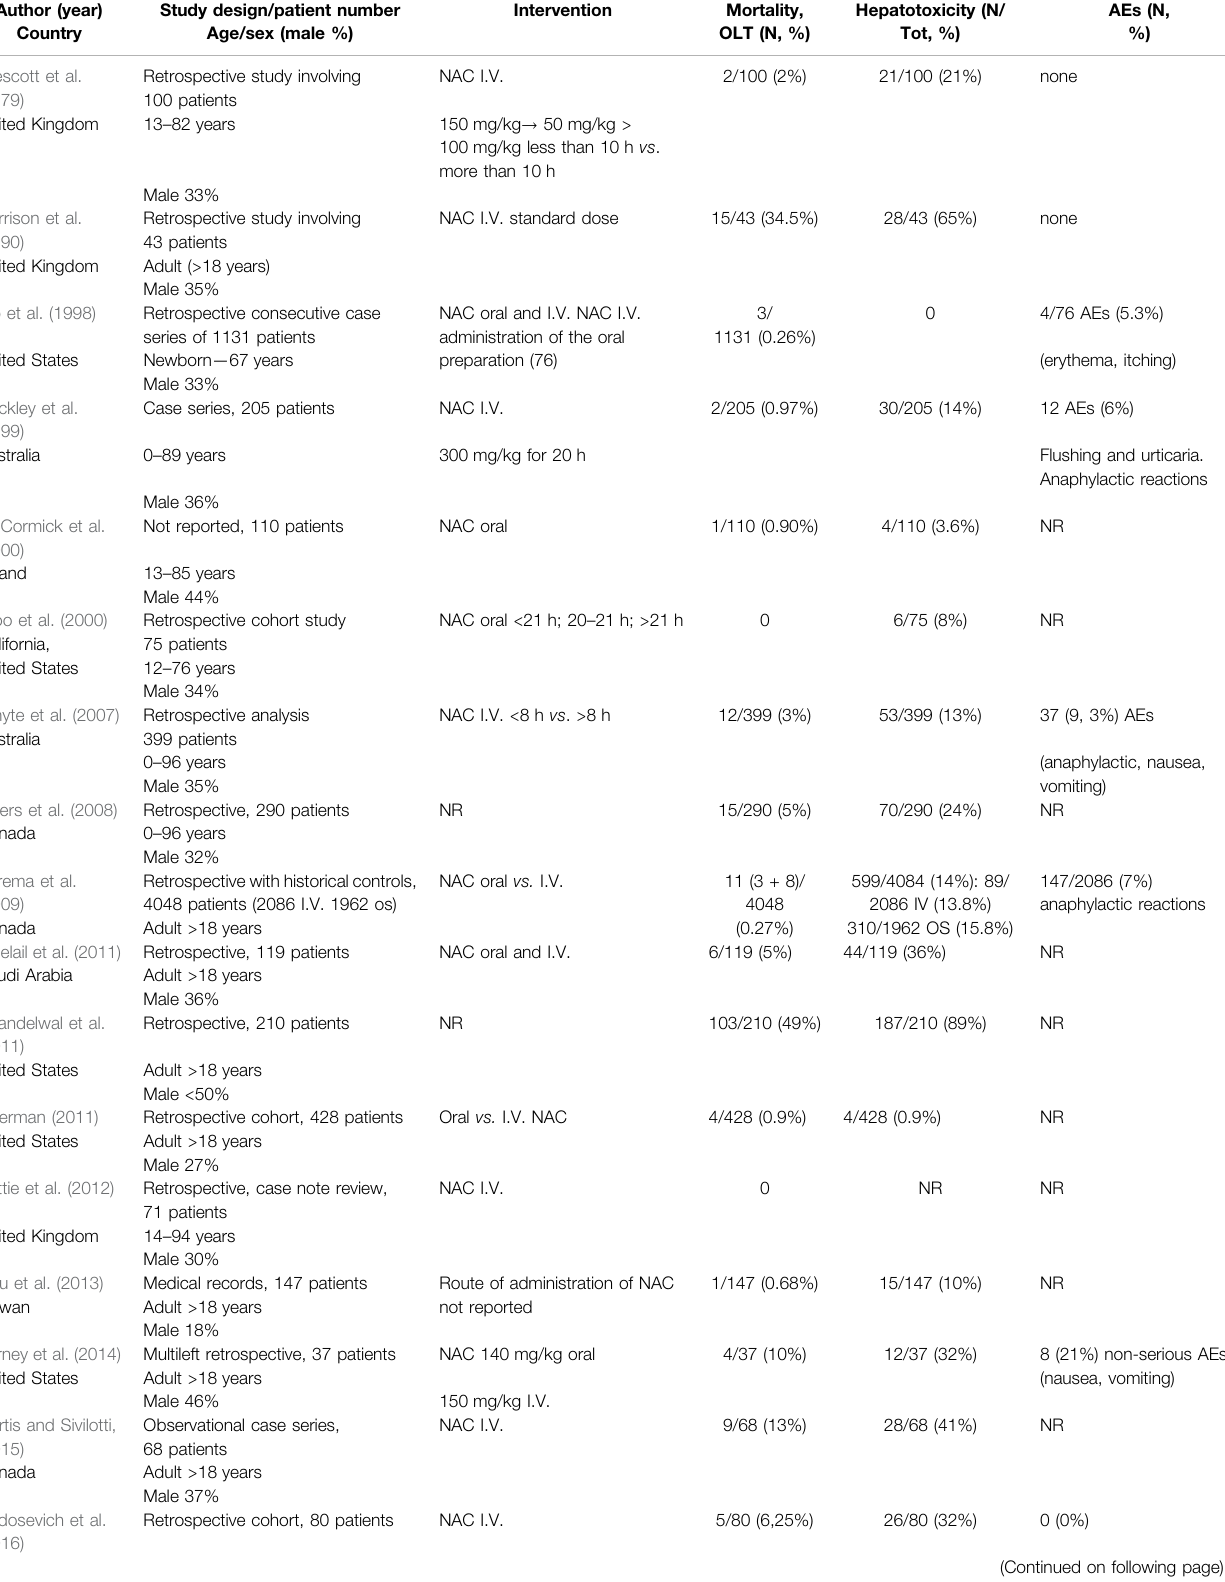
TABLE 1 | Study design, characteristics, and outcomes of 18 retrospective studies included in the